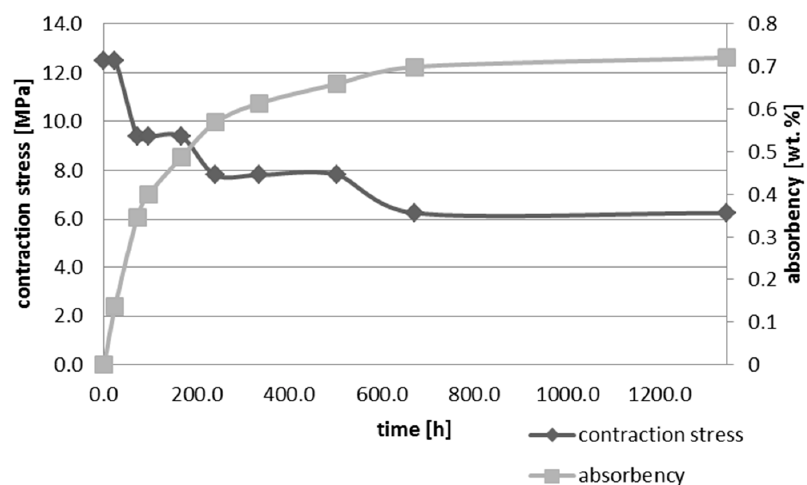
Figure 1. The influence of water sorption (56 days water immersion) on absorbency and contraction stress generated during photopolymerization of Ceram.X One.